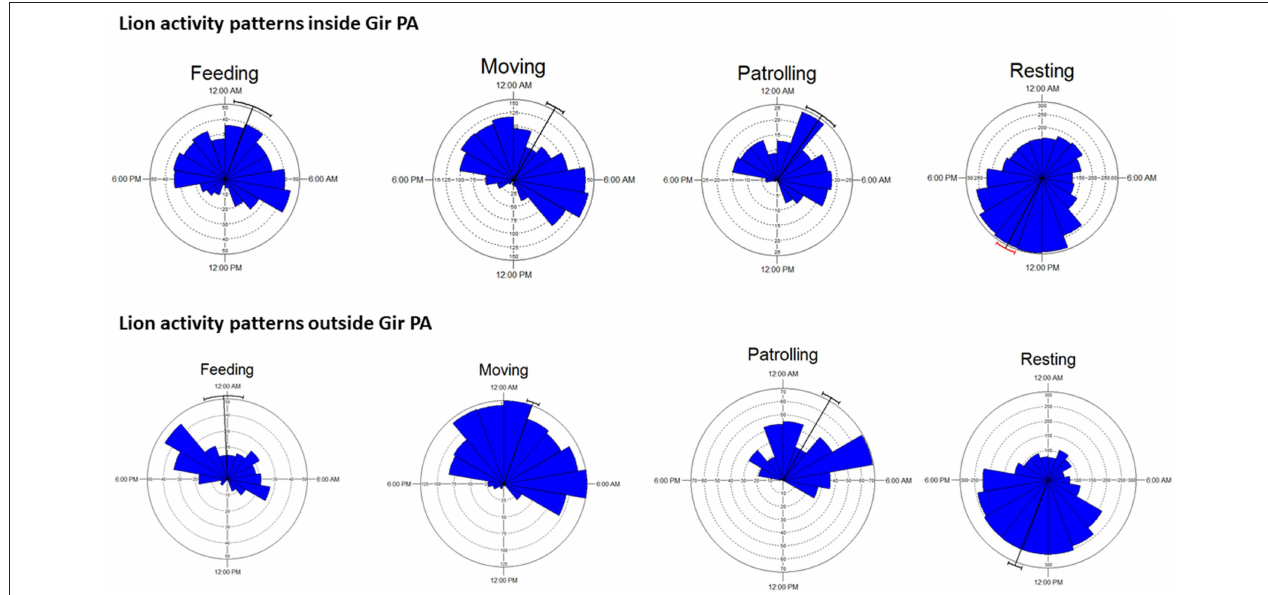
FIGURE 4 | Activity patterns of lions ( n = 27 radio-collared lions) inside and outside Gir PA based on continuous (day-night) all behavior sampling data ( ∼ 6,400h). Major behavioral states have been depicted.